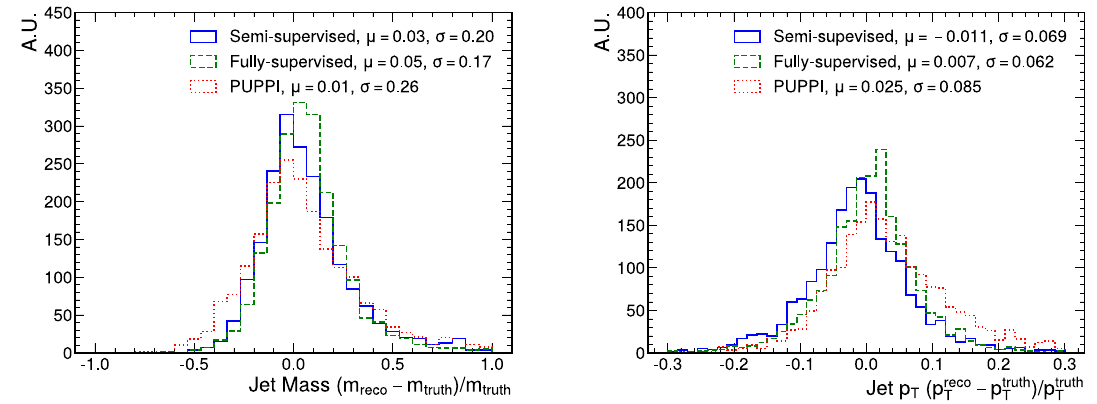
Fig. 4 Performance on jet mass and jet p T with different pileup mitigation techniques for n PU =